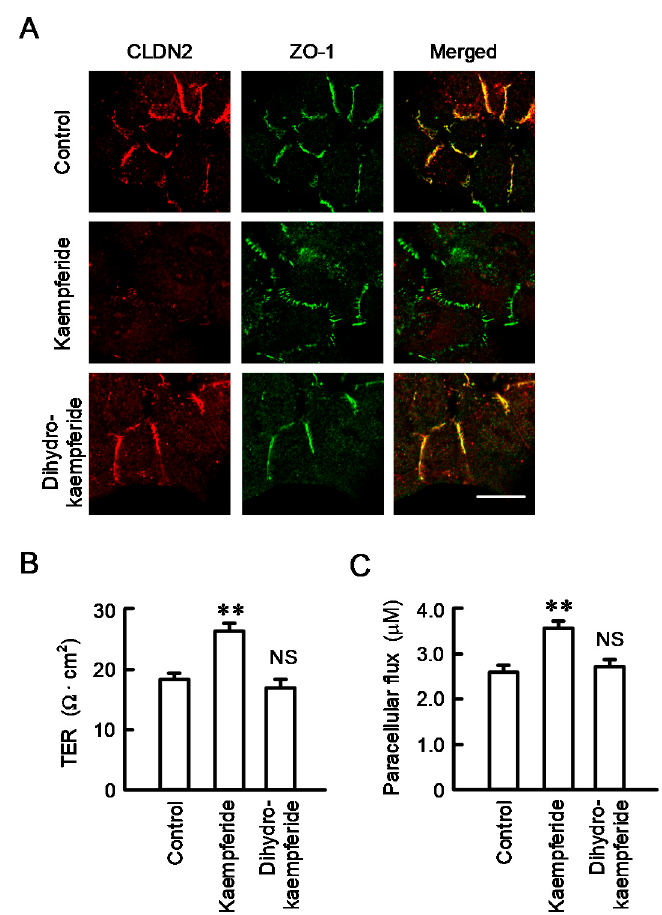
Figure 8. Effect of kaempferide on cellular localization of CLDN2 and barrier function. ( A ) Cells cultured on cover glasses were incubated in the absence and presence of 10 μ M kaempferide or 10 μ M dihydrokaempferide for 24 h. The cells were stained with anti-CLDN2 (red) and anti-ZO-1 (green) antibodies. Merged images are shown on the right. Scale bar represents 10 μ m. ( B and C ) Cells cultured on transwell inserts were incubated in the absence and presence of 10 μ M kaempferide or 10 μ M dihydrokaempferide for 24 h. TER was measured using a volt ohmmeter. doxorubicin (10 μ M) was added to the apical compartment. After incubation at 4 ° C for 60 min, the solution in the basal compartment was collected, followed by measurement of fluorescence intensity. n = 4–8. ** p < 0.01 and NS p > 0.05 compared with control (One-way analysis). TER (F 4,9 = 27.02, p = 0.0016) and paracellular flux (F 4,14 = 13.90, p = 0.00047).